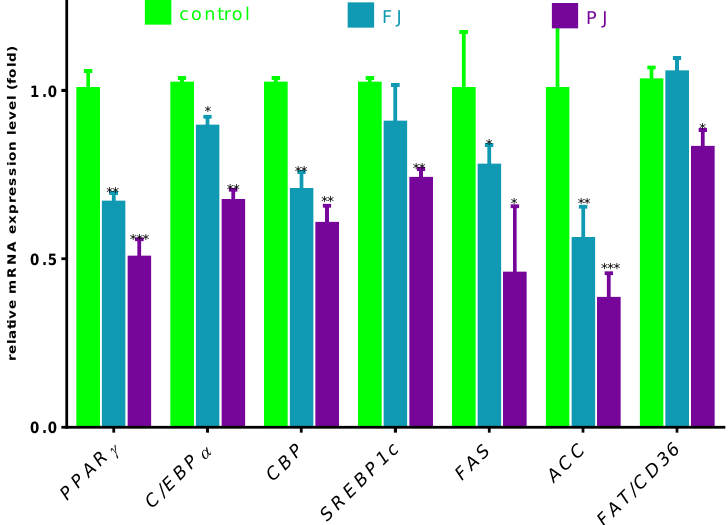
Figure 7. The influence of V. opulus FJ and PJ preparations on the gene expression in differentiated 3T3-L1 cells quantified by real-time PCR and normalized using β-actin as a reference gene. Control cells were not exposed to any compound; values are means ± standard deviations, n ≥ 4; statistical significance was calculated versus control cells (untreated), * p ≤ 0.05, ** p ≤ 0.01, *** p ≤ 0.001.